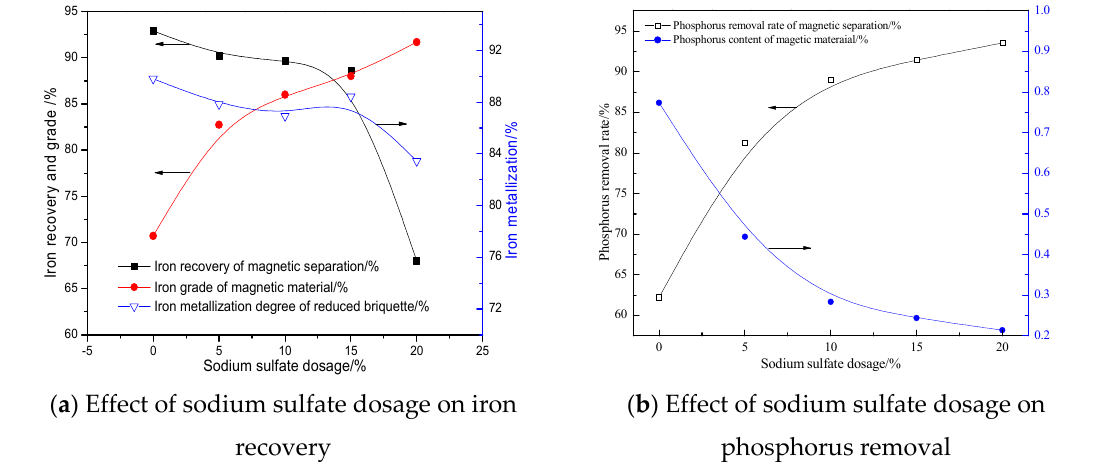
Figure 10. Effects of sodium sulfate dosage on beneficiation of iron and phosphorus removal (2.4 basicity and reducing at 1350 °C for 10 min with C/Fe = 0.48). ( a ) Effect of sodium sulfate dosage on iron recovery; ( b ) effect of sodium sulfate dosage on phosphorus removal.